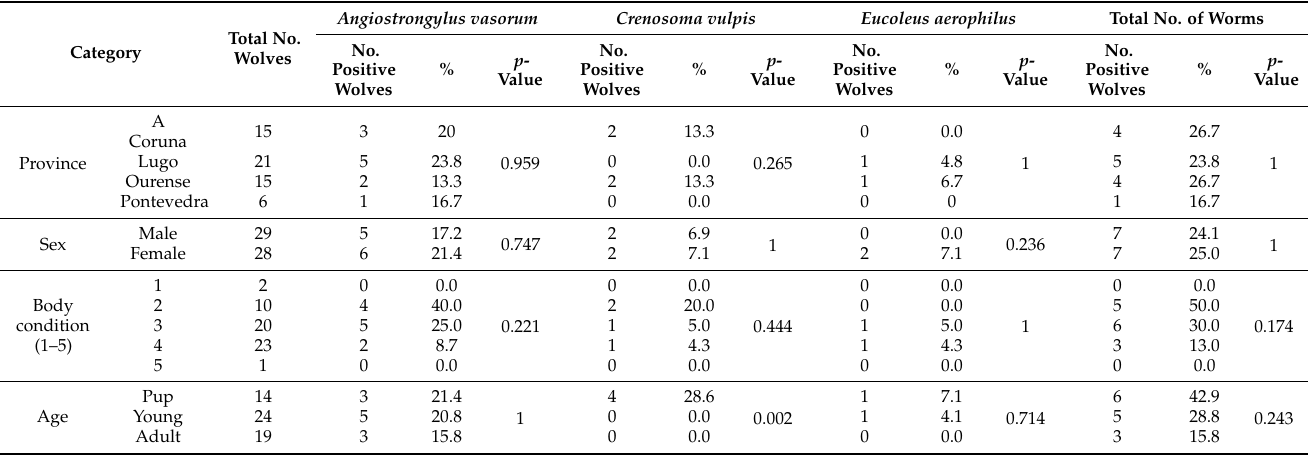
Figure 1. Cardiopulmonary nematode worms detected in wolves inhabiting the Galicia region (NW Spain). Table 2. Prevalence of Angiostrongylus vasorum , Crenosoma vulpis and Eucoleus aerophilus according to epidemiological cat- egory.